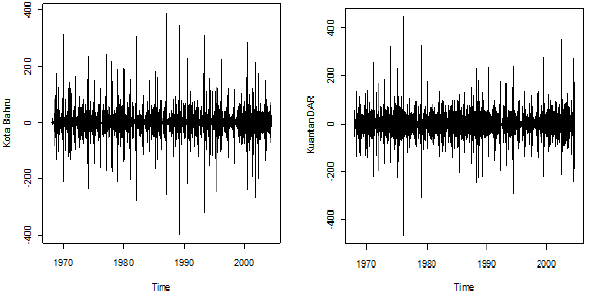
Fig. 3. Time plot of the first difference series of Kota Bharu and Kuantan.